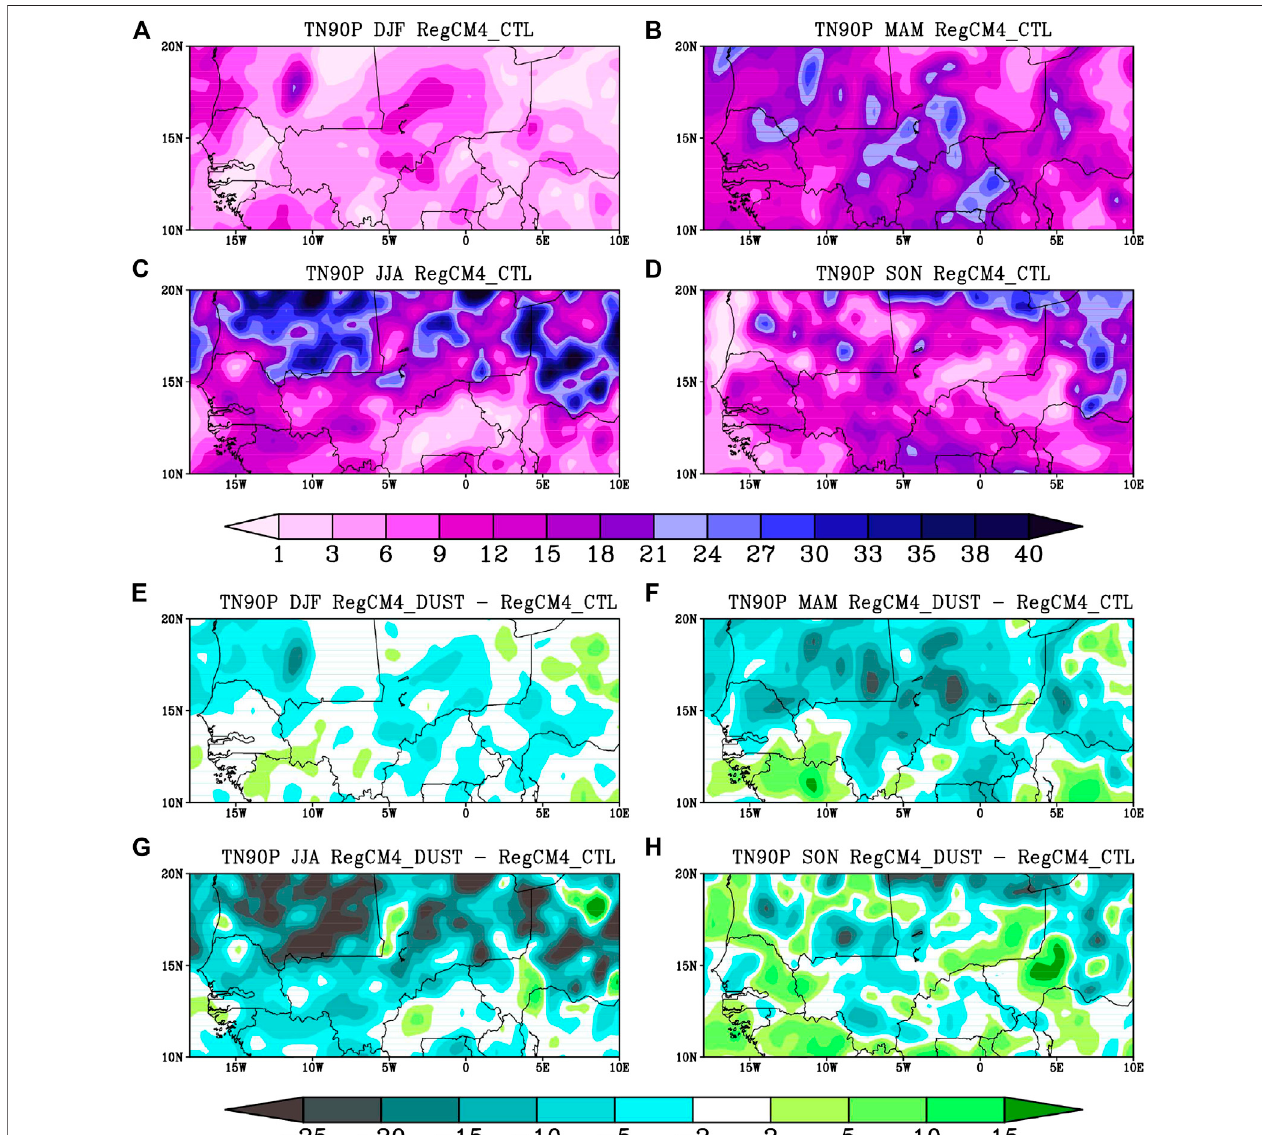
FIGURE 7 | Seasonal variability of the percentage of warm nights (TN90P) averaged from 2001 to 2010 over the Sahel: (top) RegCM4_CTL, (down) difference between RegCM4_DUST and RegCM4_CTL. The differences are signi fi cant at 95% level using the Student test.